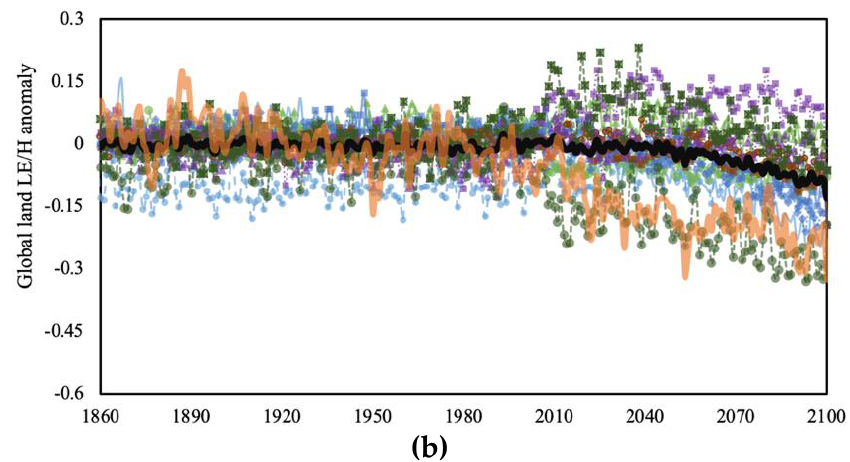
Figure 2. Anomaly of relative efficiency across the CMIP5 simulations from past to future over ( a ) sea and ( b ) land. The results between 2006 and 2100 were obtained from the RCP8.5 scenario.